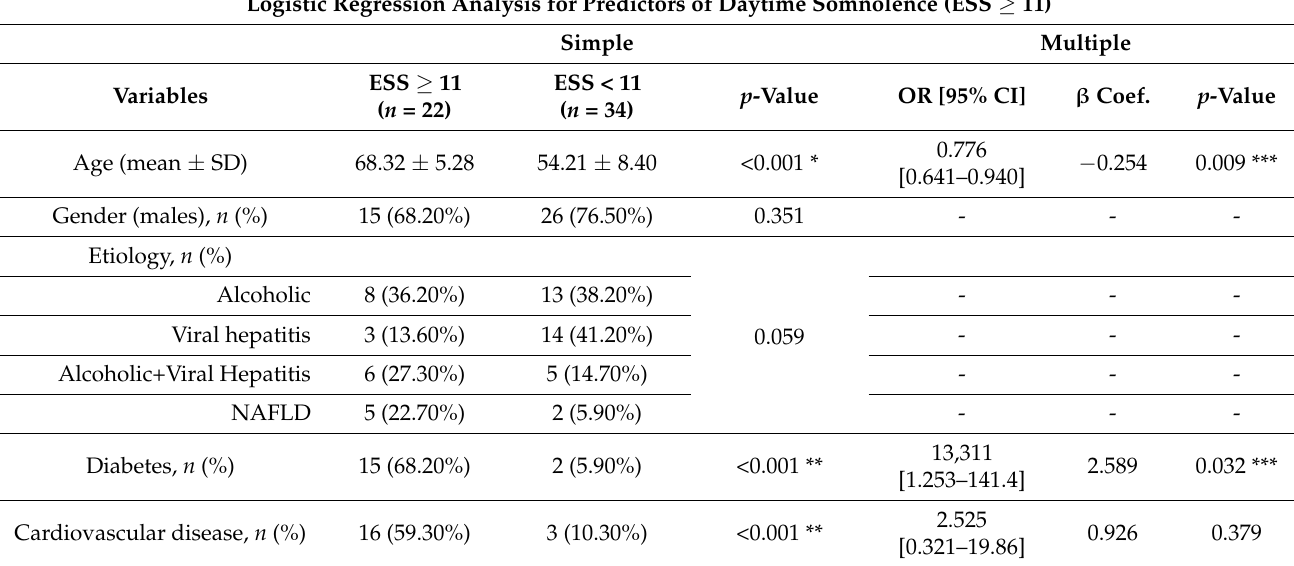
Table 5. Logistic regression analysis for predictors of daytime somnolence (ESS ≥ 11). Logistic Regression Analysis for Predictors of Daytime Somnolence (ESS ≥ 11)